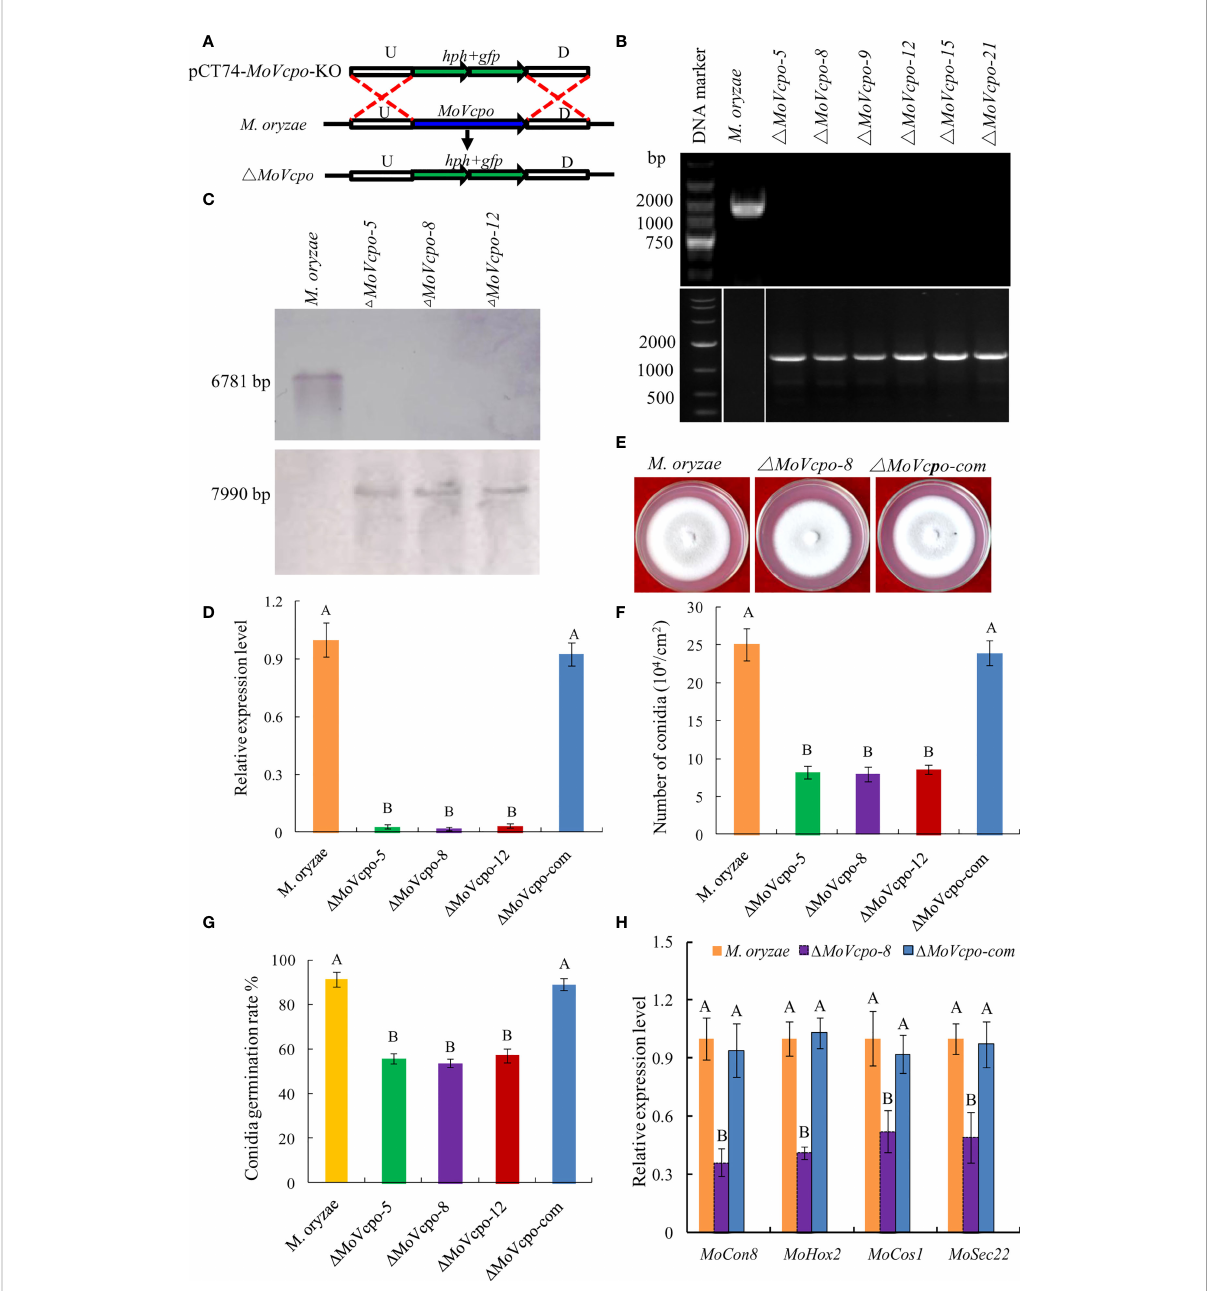
FIGURE 7 Construction, con fi rmation and characterization of MoVcpo deletion and complementation mutants. (A) Schematic strategy used for generation of MoVcpo deletion mutant according to homologous recombination. U, upstream fl anking region of MoVcpo ; D, downstream fl anking region of MoVcpo . (B) Colony morphologies on YDA medium. Photos were taken at 5 d after incubation. (C) PCR con fi rmation using MoVcpo (Upper) and hph (Lower) as probes. (D) Southern blot validation using MoVcpo (Upper) and hph (Lower) as probes, respectively. (E) RT-qPCR detection of MoVcpo expression in the deletion mutants and complementation strain. (F) Conidiation. (G) Conidia germination rate. (H) RT-qPCR analysis of the conidiation-related genes. M. oryzae , the wide-type strain; D MoVcpo - 5 , D MoVcpo-8 and D MoVcpo-12 , MoVcpo deletion mutants; D MoVcpo -com, MoVcpo complementation strain. Values are the means ( ± SE) based on three independent experiments and bars indicate standard deviations. Different letters indicate statistical signi fi cance ( p < 0.05) using Duncan ’ s new multiple range